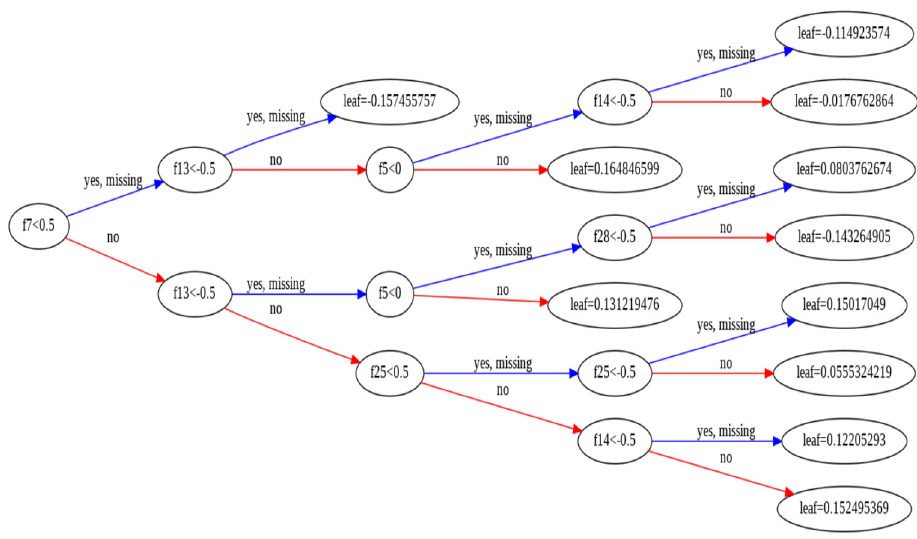
Figure 2. Visualizing gradient boosting decision tree with APBA.